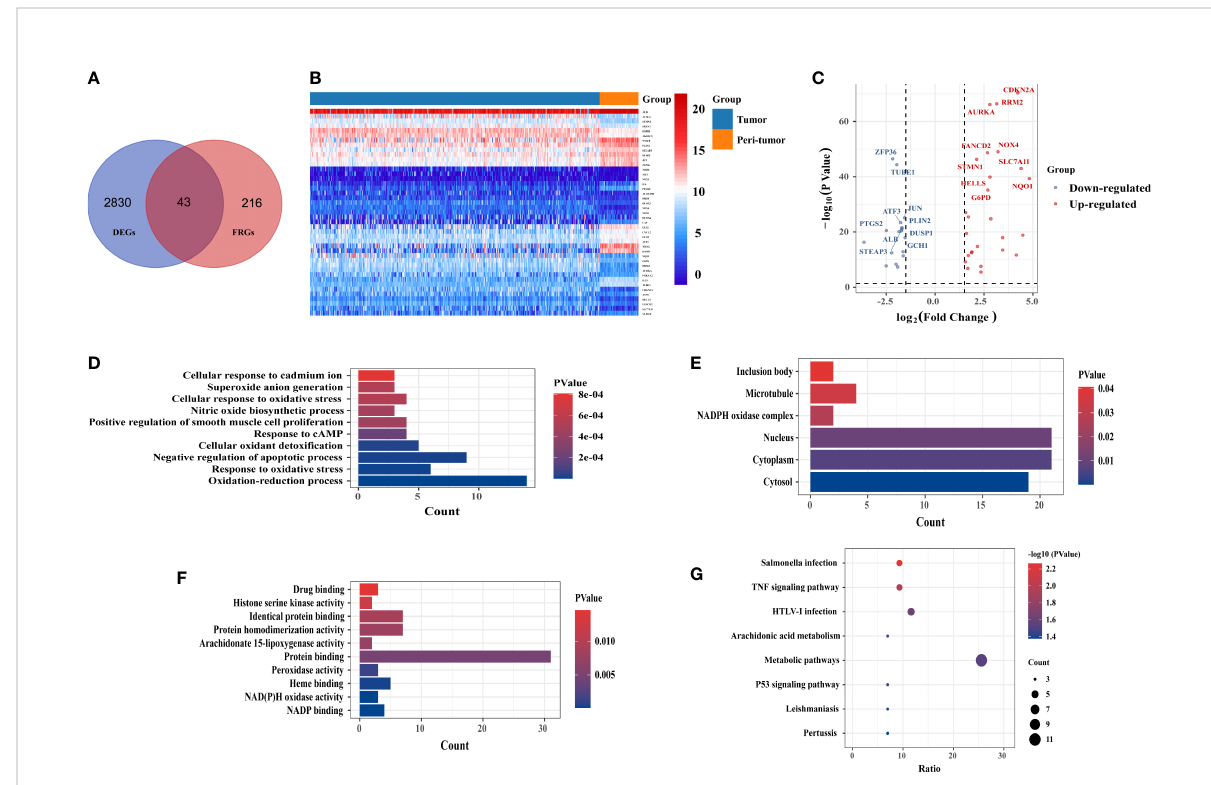
FIGURE 1 Identi fi cation of candidate ferroptosis-related differentially expressed genes (FR-DEGs) and enrichment analysis. (A) Venn plot of the 43 FR-DEGs in the TCGA-LIHC cohort. (B) the heat map showed the expression of 43 FR-DEGs in tumor and peri-tumor tissues. (C) Volcano plot of 43 FR-DEGs in TCGA-LIHC cohort. Blue dots: downregulated genes; Red dots: upregulated genes. (D) Biological processes (BP) terms. (E) Cellular components (CC) terms. (F) Molecular (MF) terms. (G) The Kyoto Encyclopedia of Genes and Genomes(KEGG)